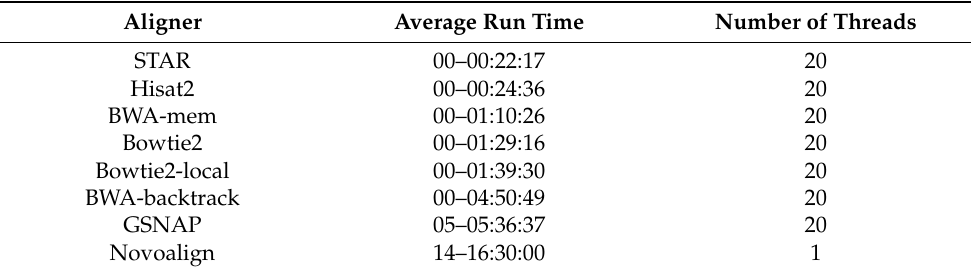
Table 1. Average run time of aligners per exome data.